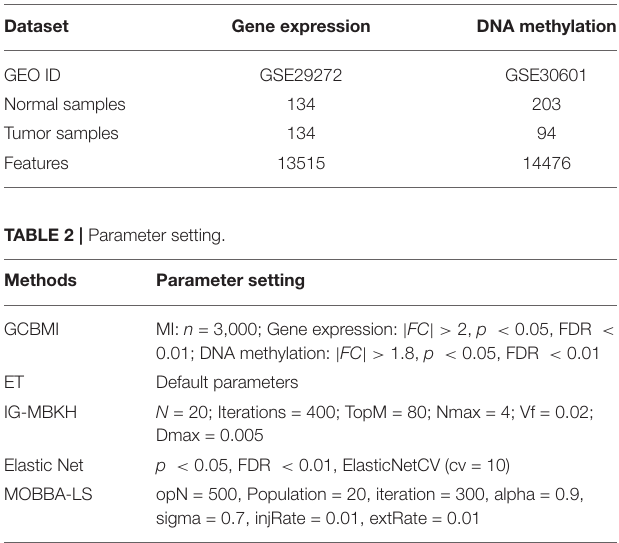
TABLE 1 | Benchmark dataset.